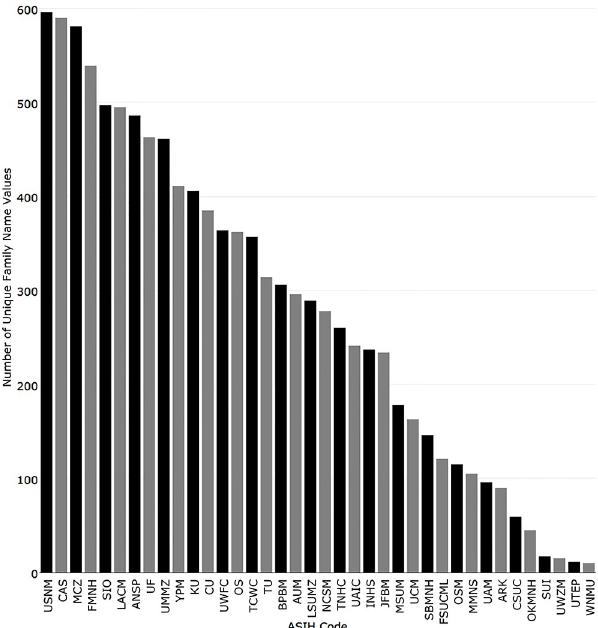
Fig 5. Number of unique family name values in records returned for the 38 fish collections with recordsets in iDigBio.